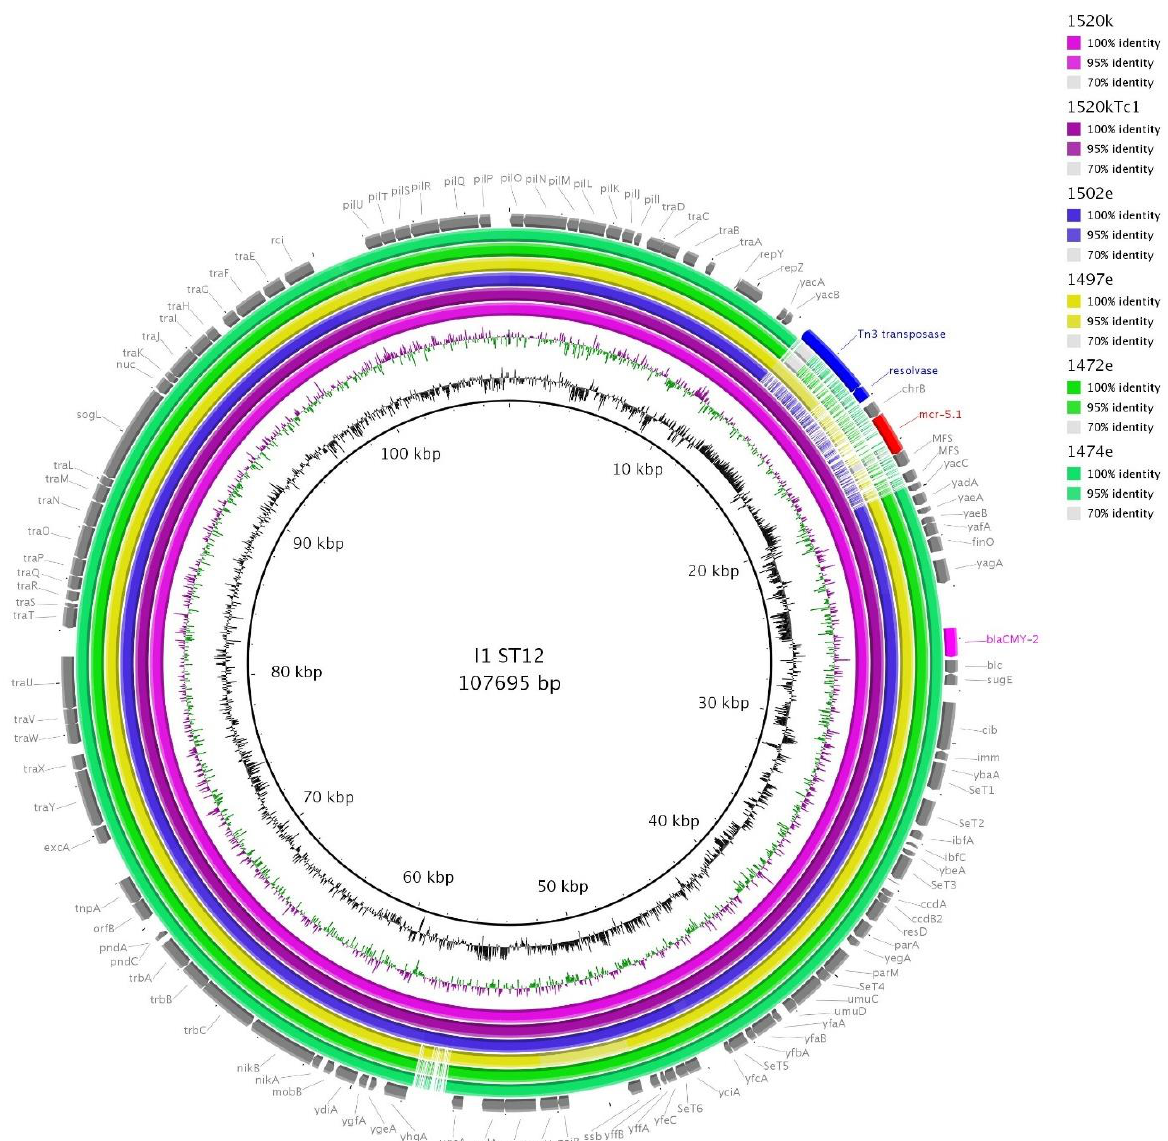
Figure 5. BRIG comparison of I1/ST12 plasmids. Reference plasmid 1520k (GenBank accession no. MW800639) obtained from PacBio was compared to Illumina data from wild type (1520k) and the respective transconjugant 1520kTc1), both purple circles. The comparison of five isolates with I1/ST12 reveals all I1/ST12 plasmids are quite conserved and share bla CMY-2 (fuchsia). They differed only in part with the transposon carrying mcr-5.1 (red) in 1520k, mobile genetic elements of this transposon are highlighted in blue.